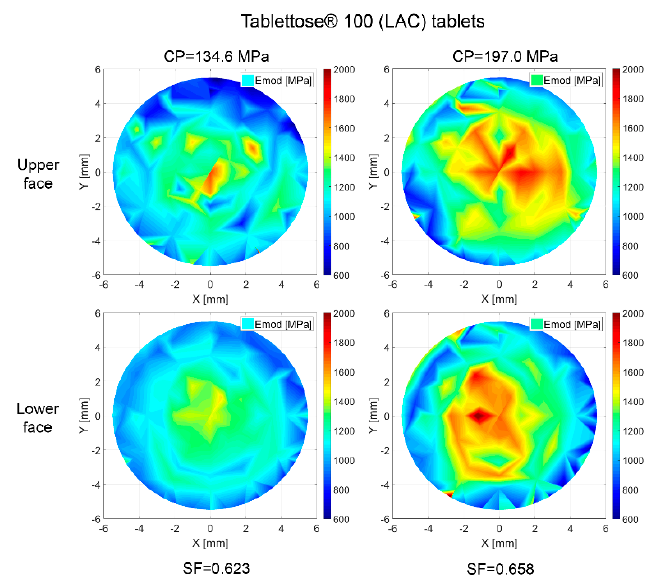
Figure 17. E mod distribution throughout the tablet surface for LAC tablets. Coordinates [0, − 5.625] correspond to the frontal part during compaction. The filling shoe approaches from [ − 5.625, 0] with a rotational cycle and it withdraws following its same path to [5.6250, 0]. Sampling: eight tablets per pressure and face; 79 indents at each tablet face.